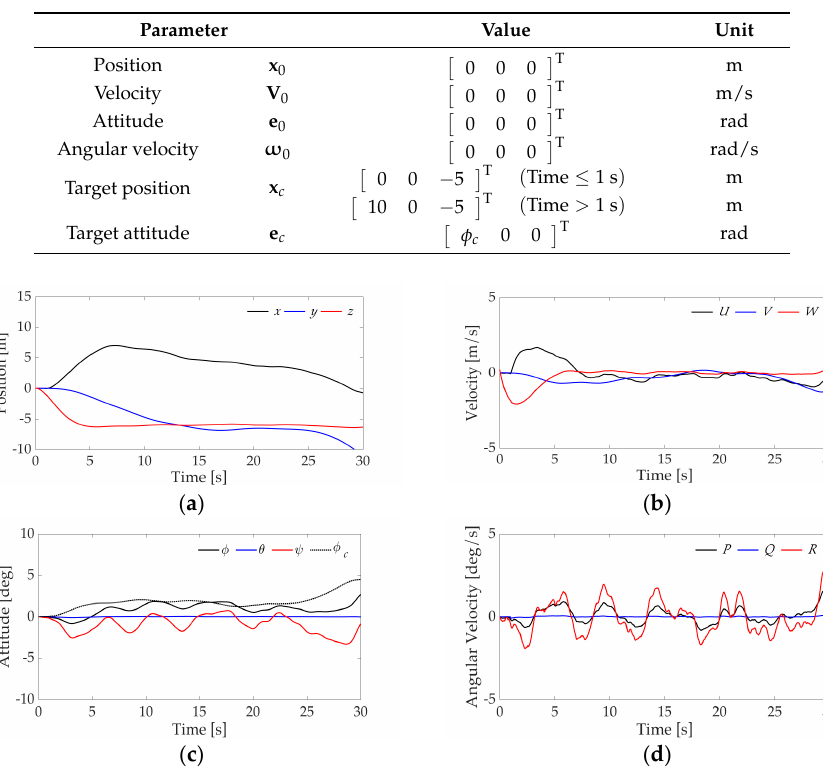
Figure 11. Time responses of state variables using conventional controller. ( a ) Position; ( b ) Velocity; ( c ) Attitude; ( d ) Angular velocity.